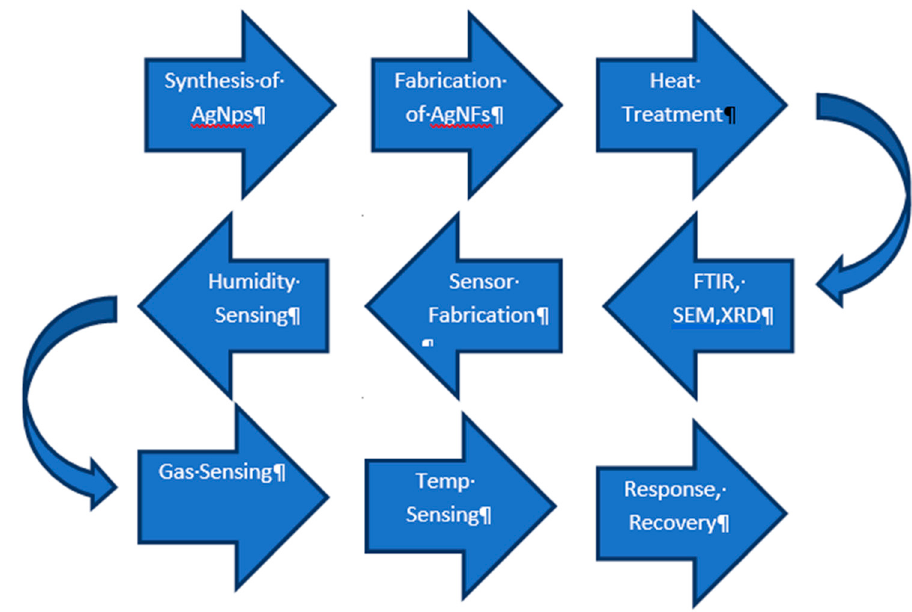
Figure 1. Flow chart for the research methodology, characterization, fabrication, and sensing.